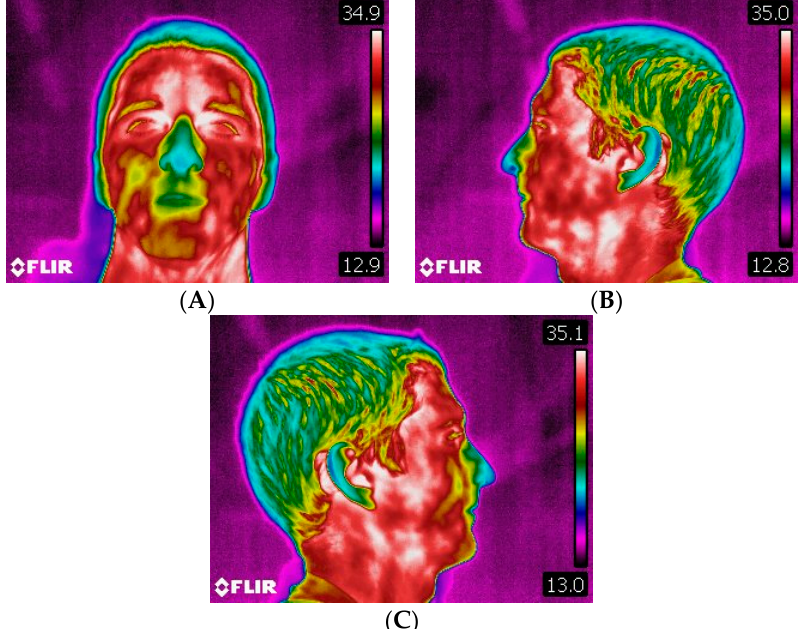
Figure 7. ( A ) Frontal thermogram. ( B ) Left side profile thermogram. ( C ) Right side profile thermogram.